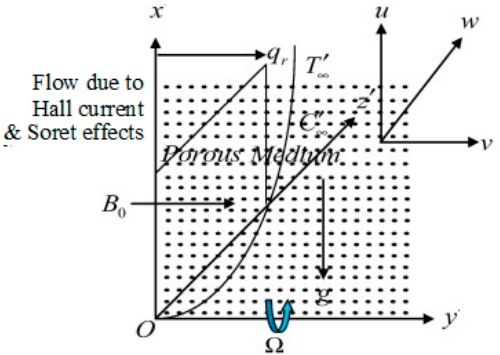
Figure 1. The geometry of the problem.